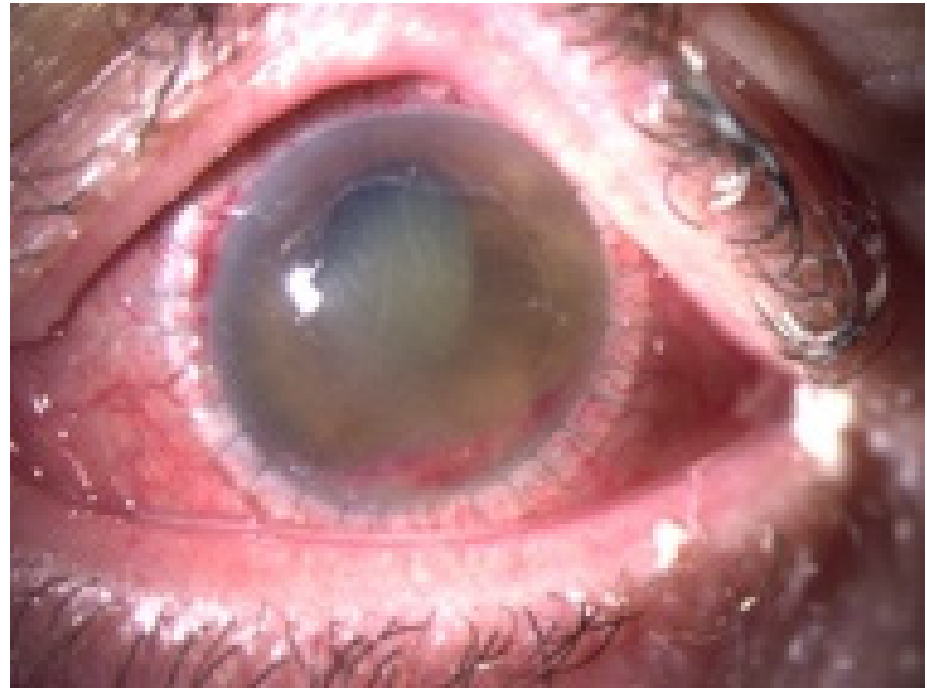
Figure 5. Biomicroscopic slit-lamp photography of the left eye one week after a large-diameter (13.0 mm) repeat keratoplasty with again white-viscous material in the inferior iridocorneal angle.